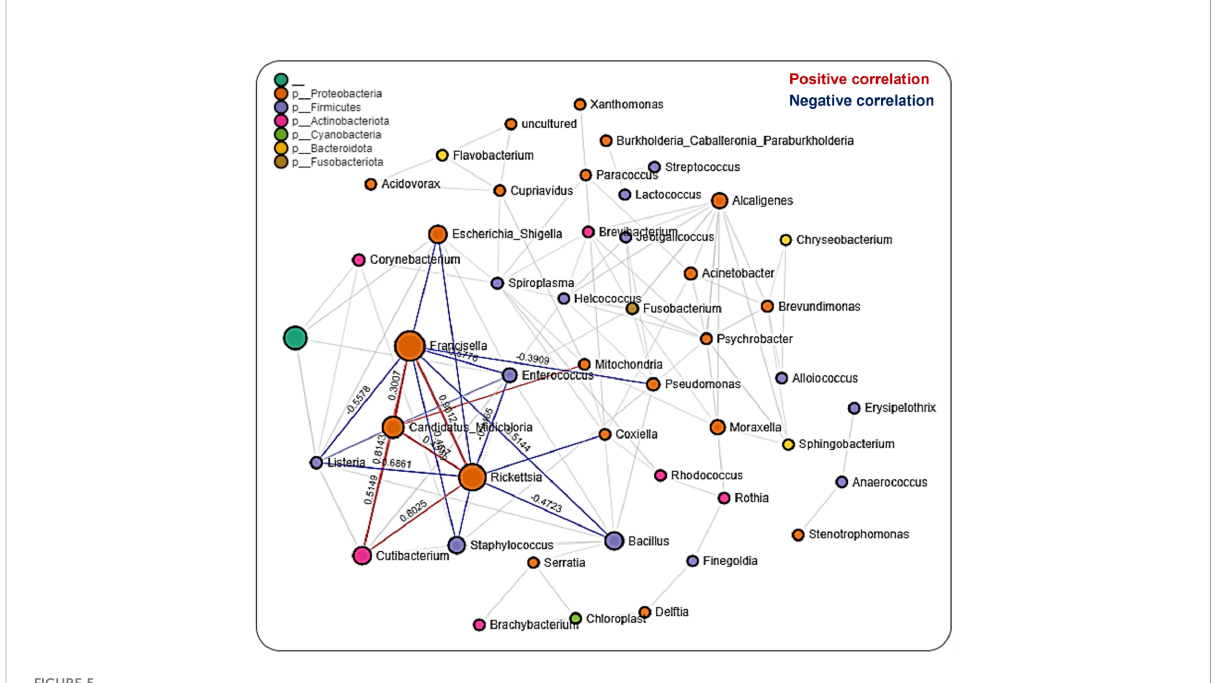
FIGURE 5 Correlation network analysis across tissue stages of Am. maculatum ticks. Correlation network generated using the SparCC algorithm. Correlation network with nodes representing taxa at the family level and edges representing correlations between taxa pairs. Node size correlates with the number of interactions in which a taxon is involved, and the line color represents either positive (red) or negative (blue) correlations. The color-coded legend shows the bacterial family to which each taxon